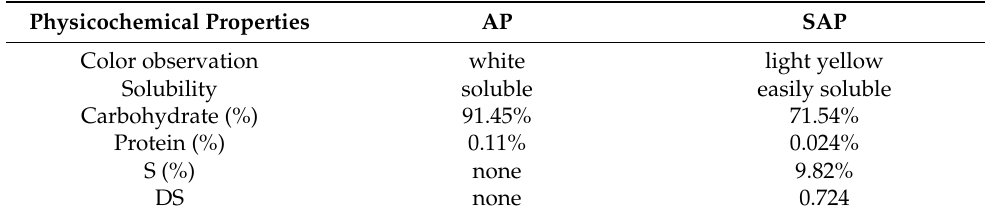
Table 4. Physicochemical properties of the polysaccharide